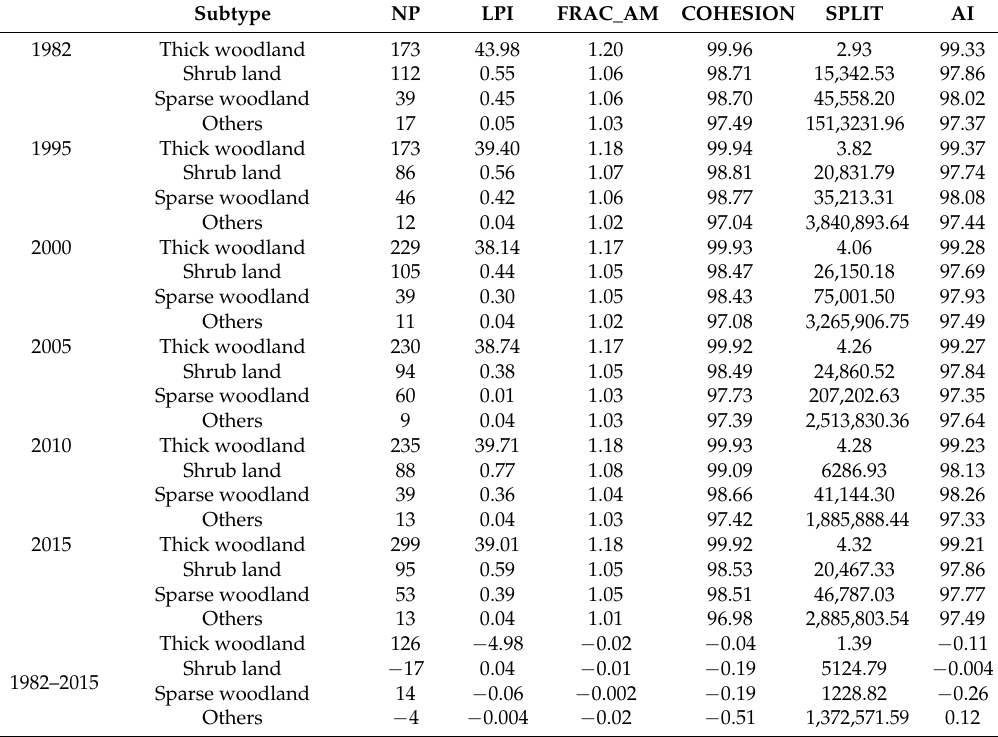
Table 6. Class-level metrics for forestlands in the Naoli River catchment.